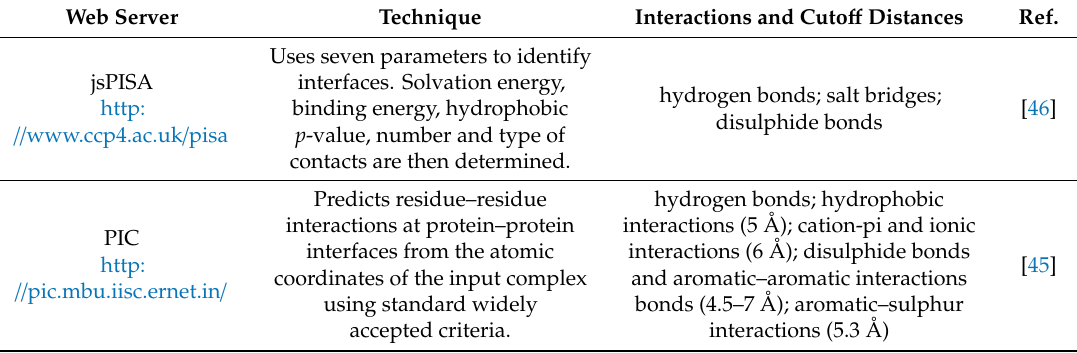
Table 2. Web servers used for the prediction of interactions across the subunit interfaces in this study. Web Server Technique Interactions and Cuto ff Distances